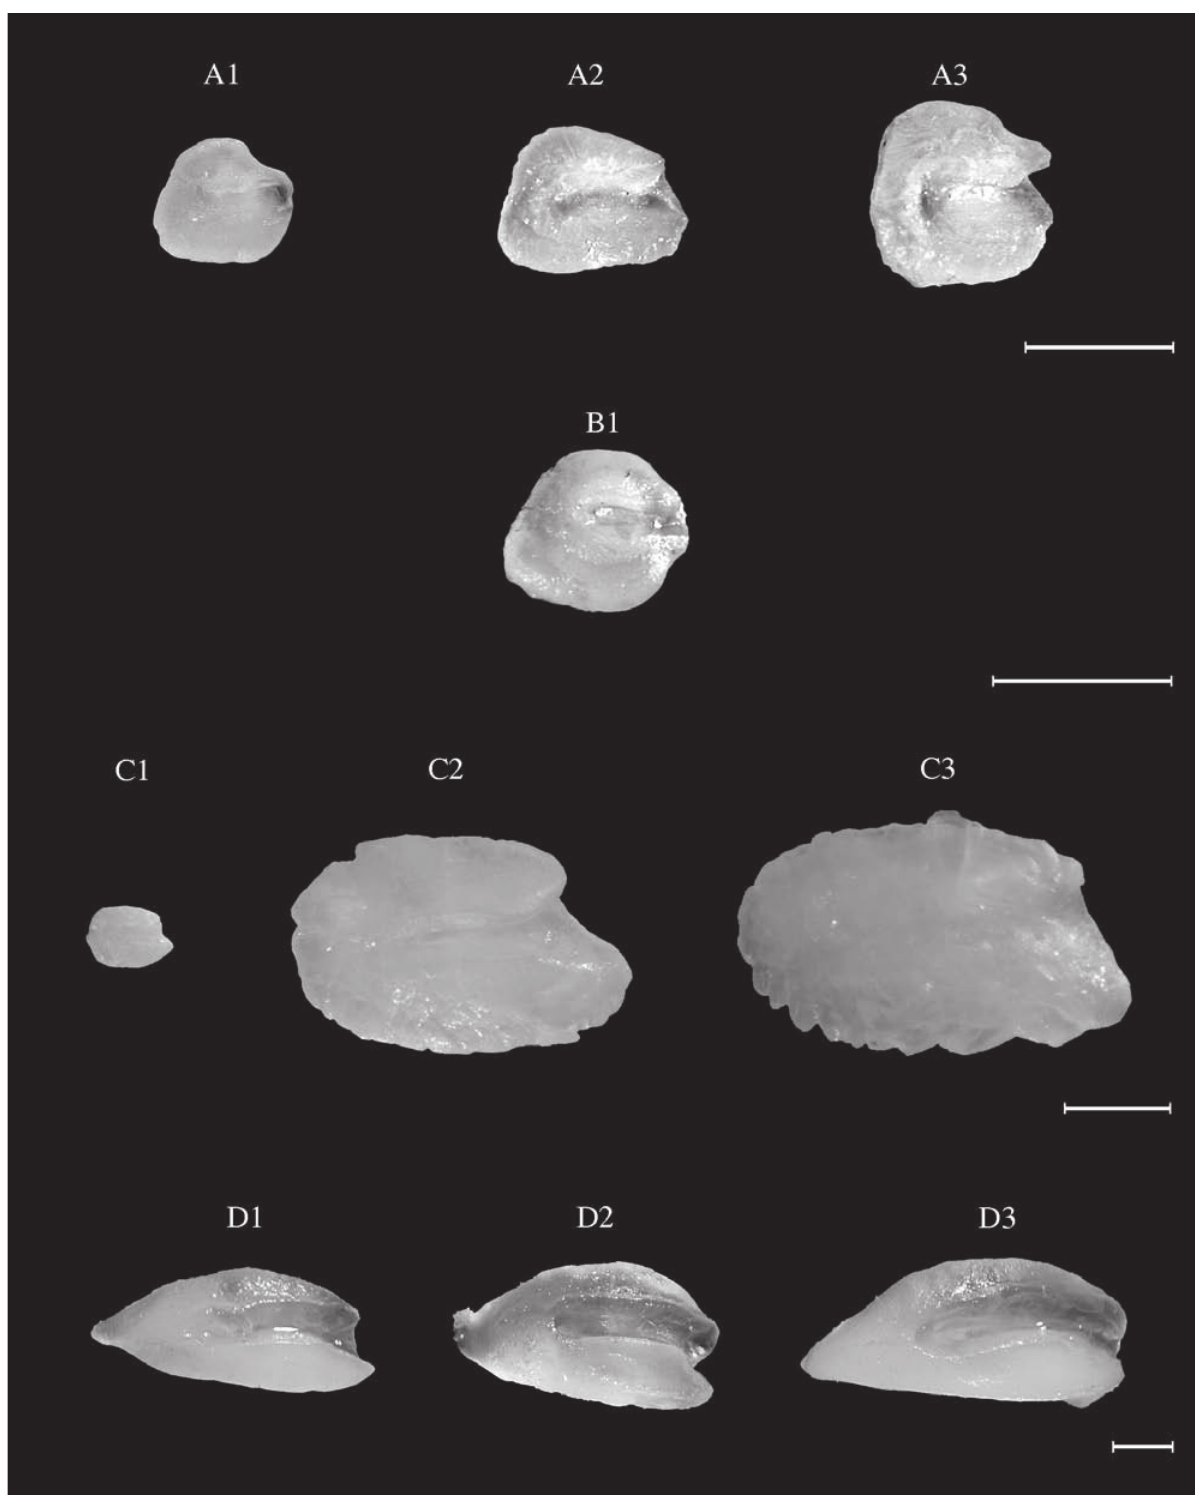
Fig. 10. – Notacanthus bonaparte . TL: A1, 24.9 cm (NEA); A2, 23.5 cm (WM); A3, 25.0 cm (WM). Polyacanthonotus rissoanus (WM). TL: B1, 20.0 cm. Anguilla anguilla (NEA). TL: C1, 12.0 cm; C2, 40.0 cm; C3, 85.7 cm. Enchelycore anatina (CEA). TL: D1, 74.0 cm; D2, 84.5 cm; D3, 88.7 cm. Scale bar = 1